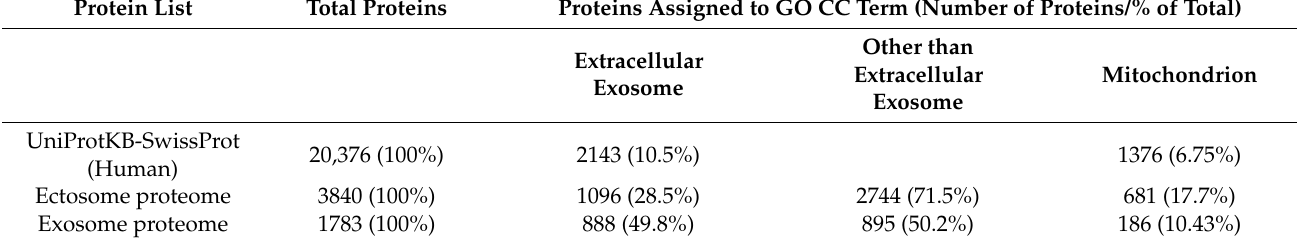
Table 1. Mitochondrion and extracellular exosome GO CC term enrichment in proteins identified in the exosome and ectosome samples. Full human proteome composition for the same terms is shown for